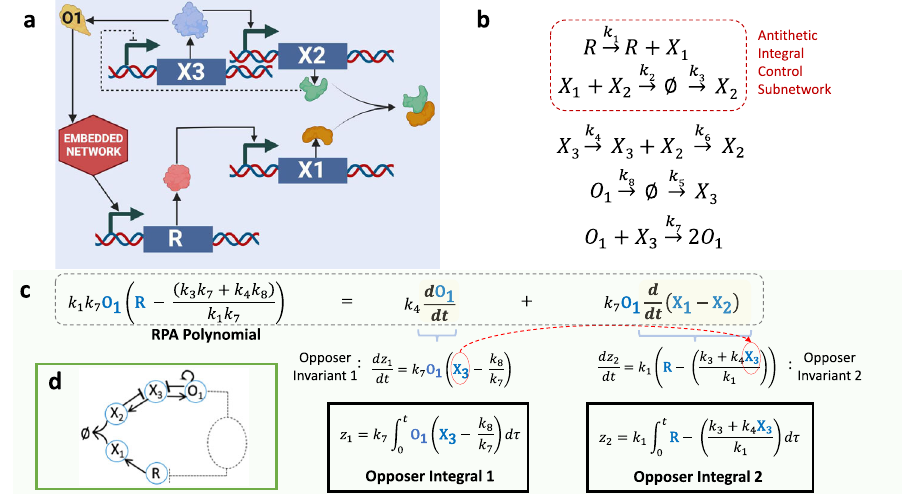
Fig.2|ACRNcontainingtheantitheticintegralcontrolmotifasasubnetwork. a Closed-loop system for an antithetic integral controller ( X1 , X2 ), along with an interconnected auxiliary controller ( X3 , O1 ). Created with BioRender.com. b Chemical reactions for the CRN. c The CRN implements integral control via two independent internal models, corresponding to two independent polynomial